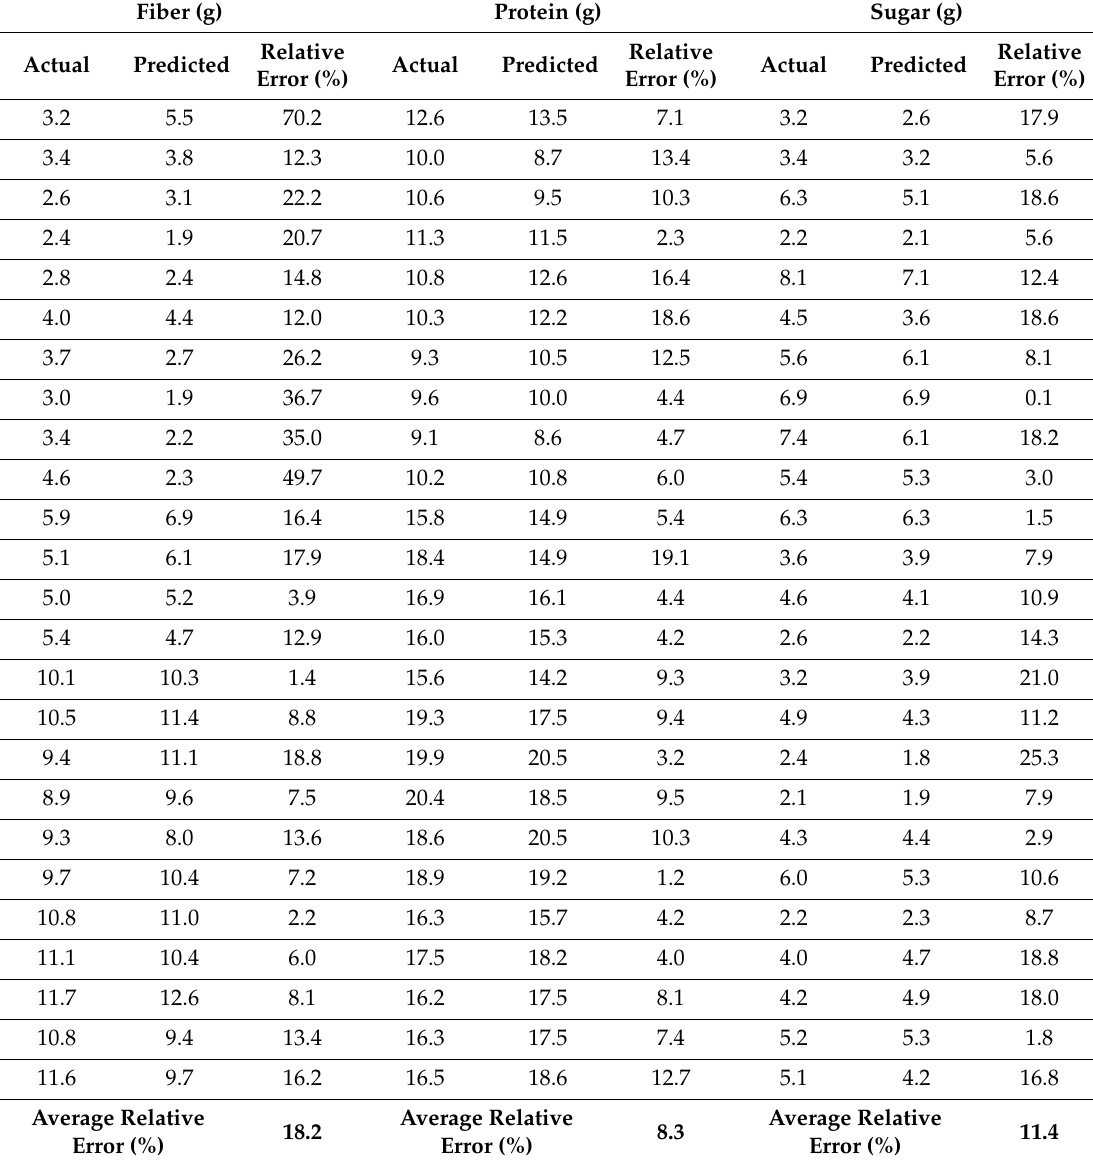
Table 4. The actual and predicted nutritional parameter content and relative error obtained for the test set samples per serving via the individual PLS models developed for fiber, protein and